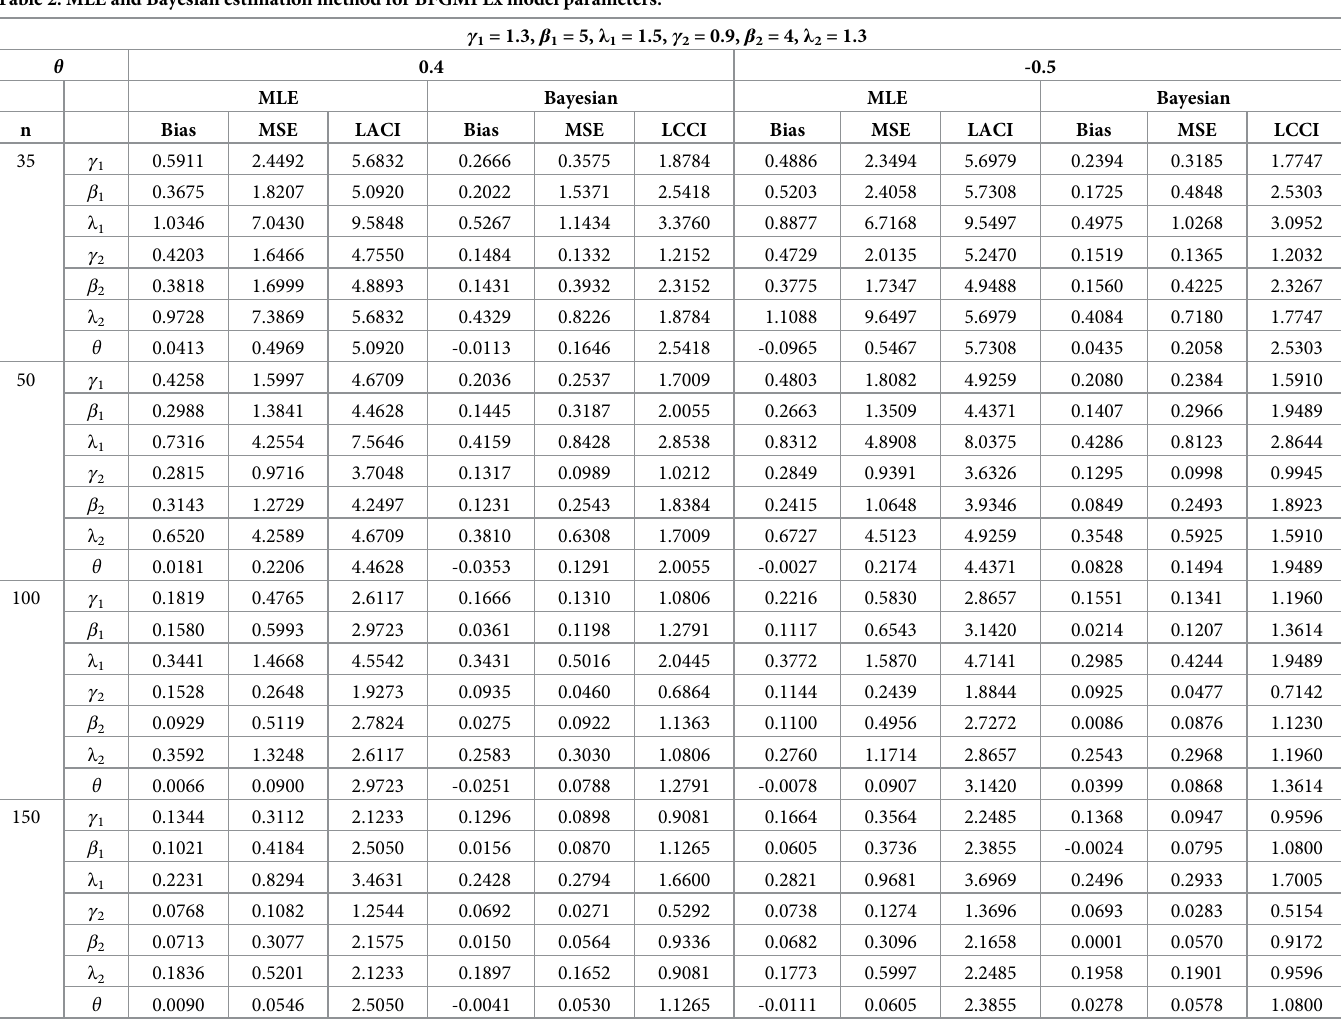
Table 2. MLE and Bayesian estimation method for BFGMPLx model